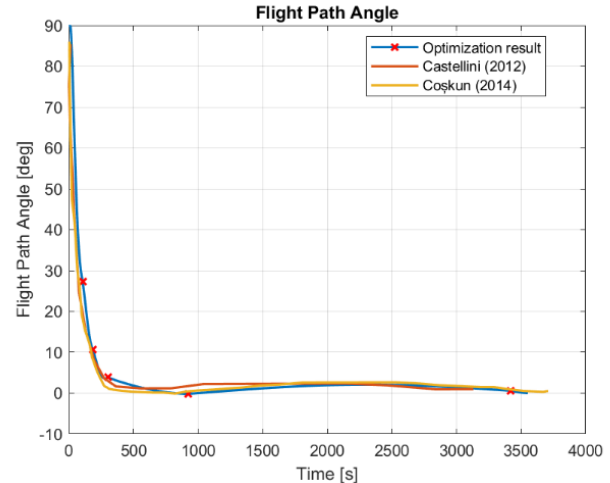
Figure 7. Flight path angle in the optimized trajectory. The red marks indicate the staging or coasting phase.